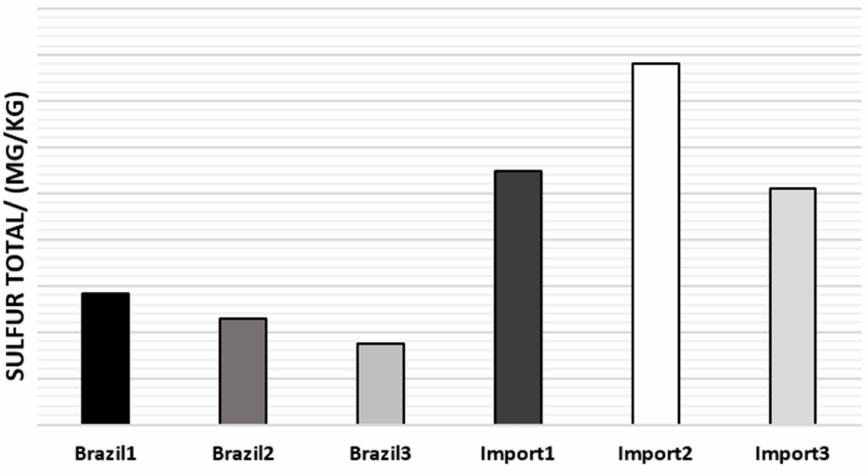
Figure 6. Average total sulfur content in the naphtha